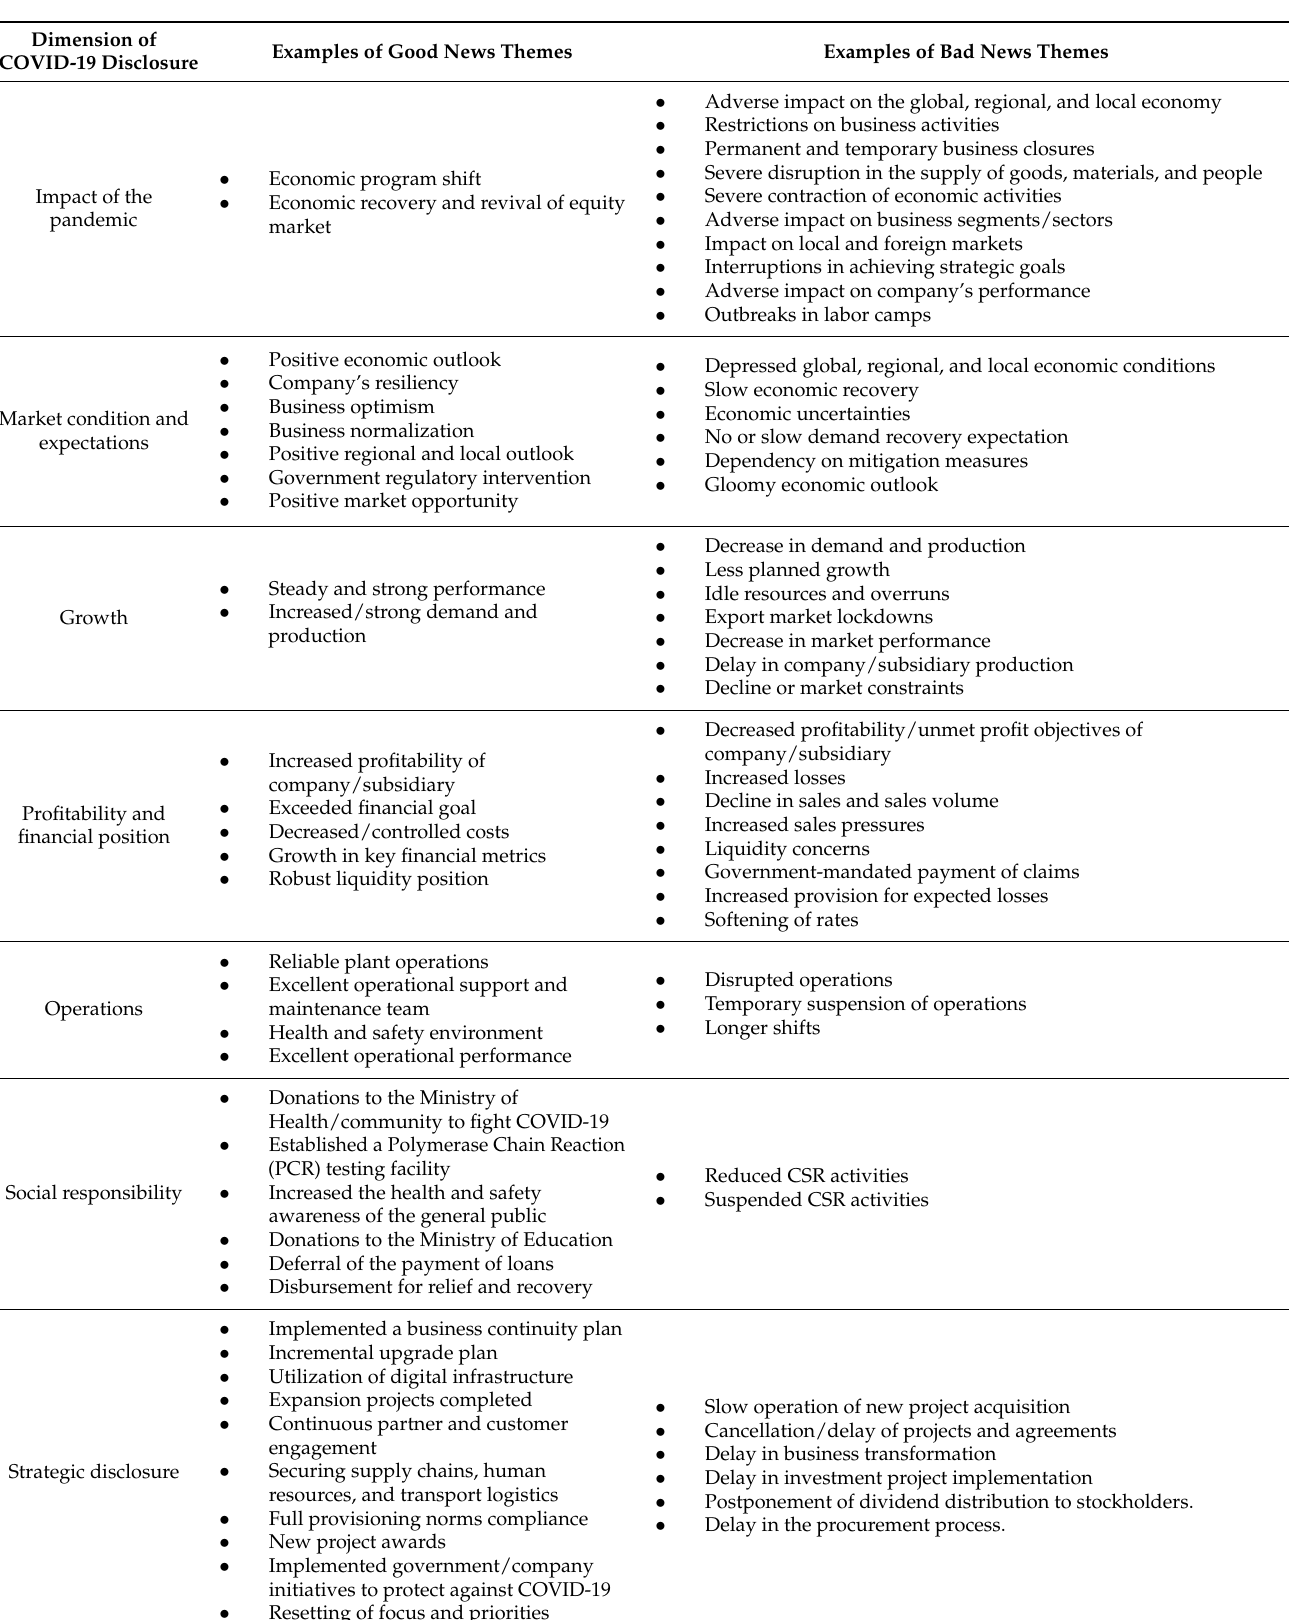
Table 1. Dimensions of COVID-19